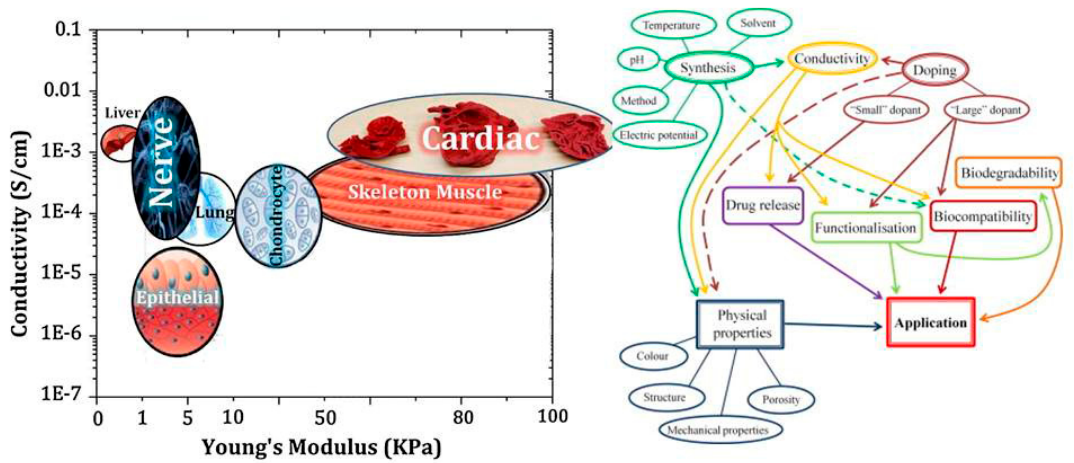
Figure 1. Conducive platform’s properties are adjustable with various tissues [14,43]. The plot in the